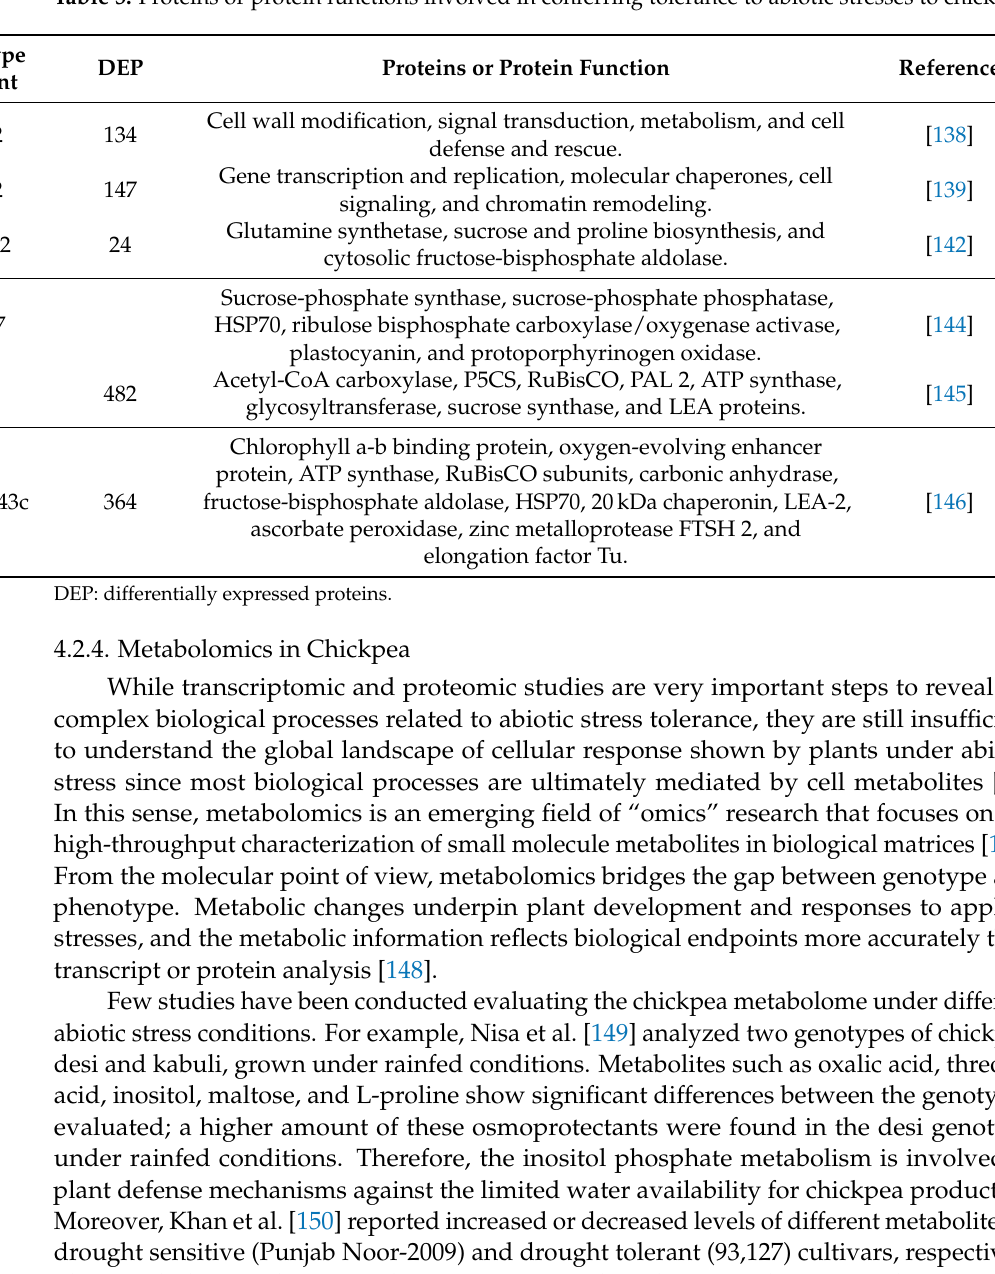
Table 5. Proteins or protein functions involved in conferring tolerance to abiotic stresses to